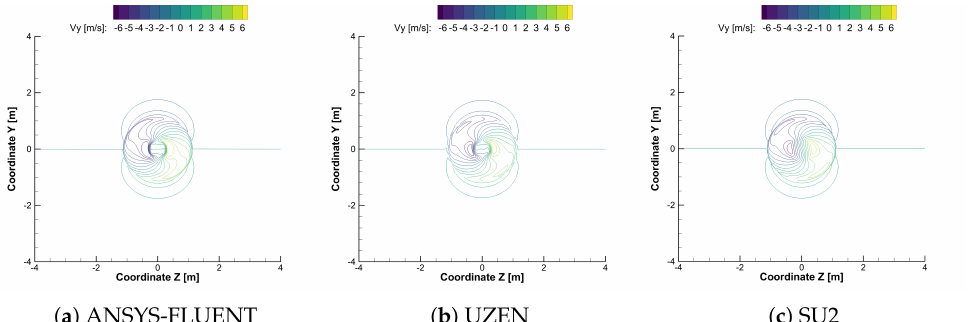
Figure 6. Comparison of x component velocity at section z = 0 m.